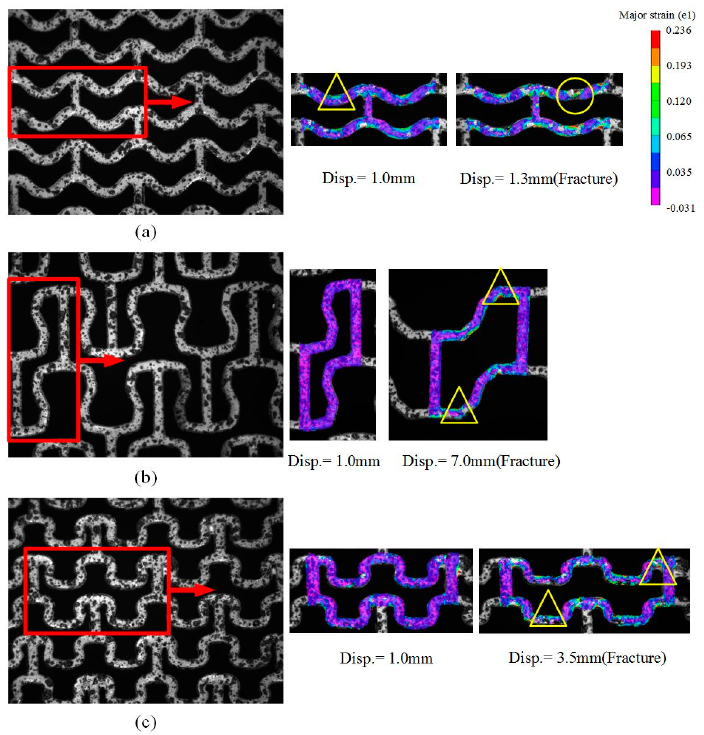
Figure 9. Speckle images and major strain distributions of the stent meshes during the stretching tests of the stents with: ( a ) Pattern A, ( b ) Pattern B, and ( c ) Pattern C. Triangle: strain concentration; Circle: Fracture.